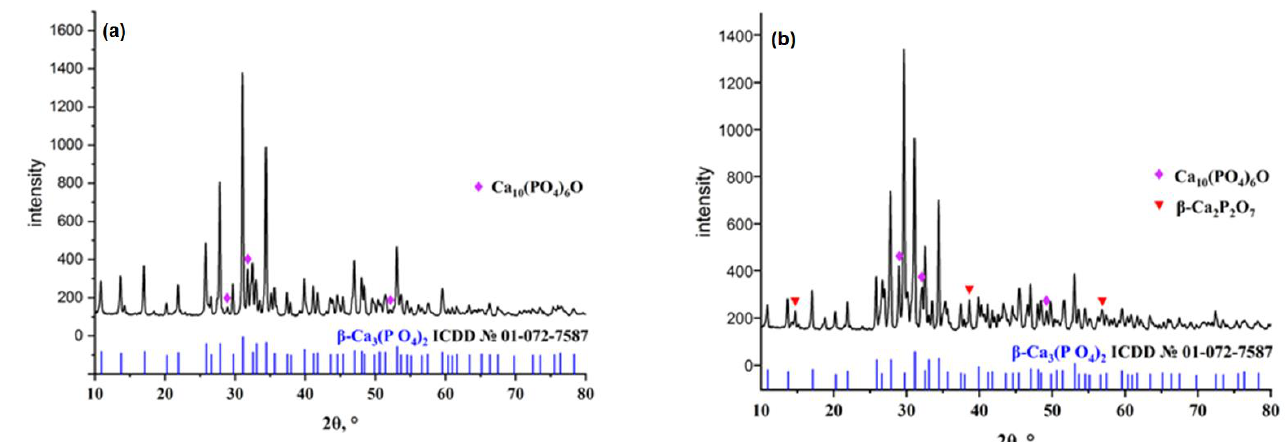
Figure 1. Sample left to mix for 12 h: ( a ) β -Ca 3 (PO 4 ) 2 , ( b ) Ca 10 (PO 4 ) 6 O.